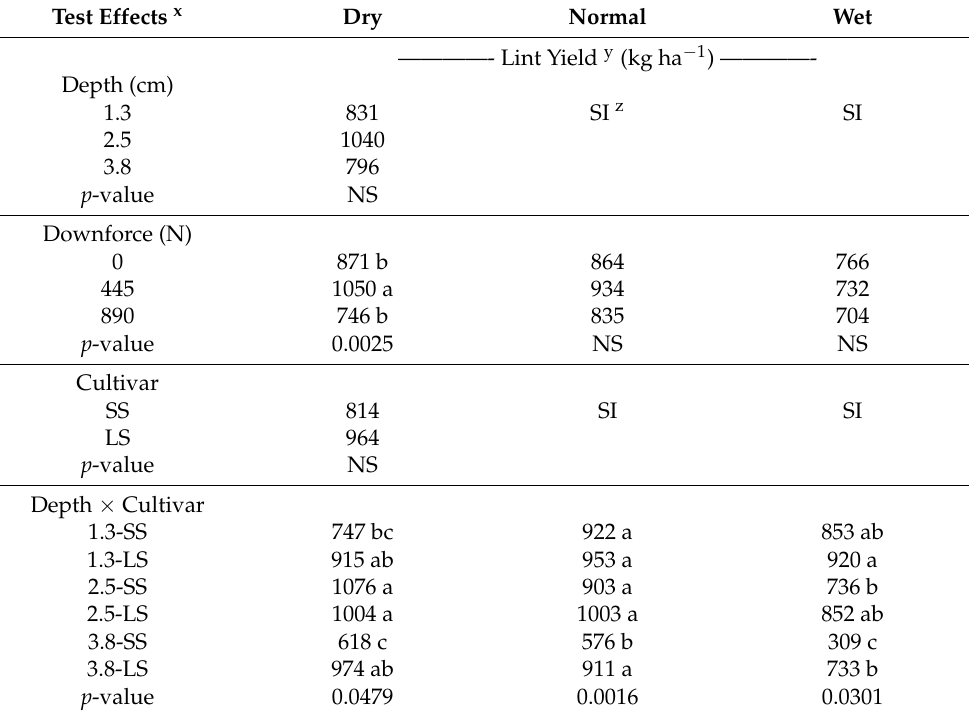
Table 10. Influence of seeding depth, downforce, cultivar, and depth × cultivar on lint yield in different at-plant field conditions in 2017.